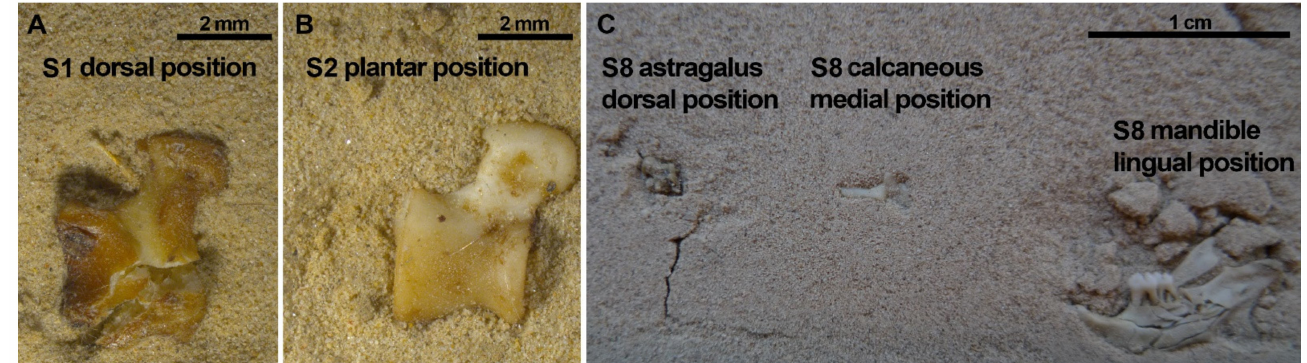
Figure 11. Astragali usually stayed complete after compression (75%) except for two cases in which both were positioned in a dorsal aspect and compressed dry. ( A , B ) show astragali from the same SET 1, resulting in one of the astragali breaking while the other remained complete during the 3rd Step of compression. Calcanei were never broken during compression (Table S5). On the right picture ( C ), SET 8, the calcaneus and the astragalus appear complete, in contrast to the mandible that is highly broken despite these elements from SET 8 were immersed in water before